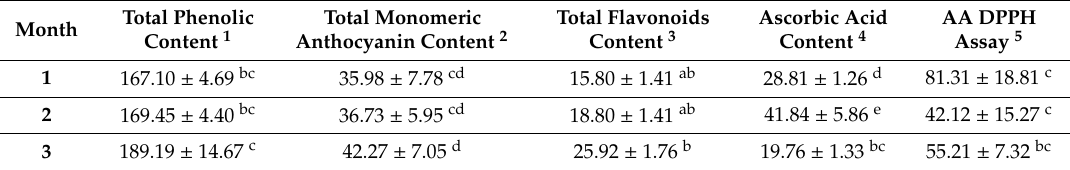
Table 8. Fruits stored at –20 ◦ C in freezer, packaged in PET film. E ff ect of storage period on the total phenolic content, total monomeric anthocyanin content, total flavonoid content, the ascorbic acid content, and the antioxidant activity DPPH parameters in red raspberries (cv. Erika). The results are the mean of three replicates ± Standard Deviation. ** ( P ≤ 0.01). The letters represent the significant di ff erence vertically at P ≤